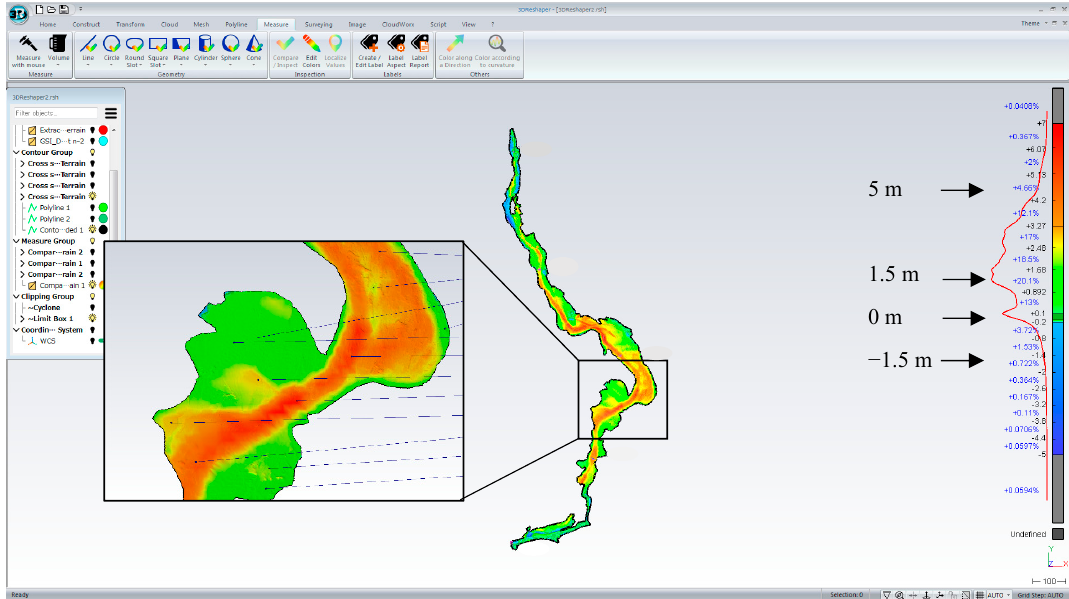
Figure 11. Topographical change estimated by PB and DEM before the disaster (positive values denote deposition and negative values denote erosion).